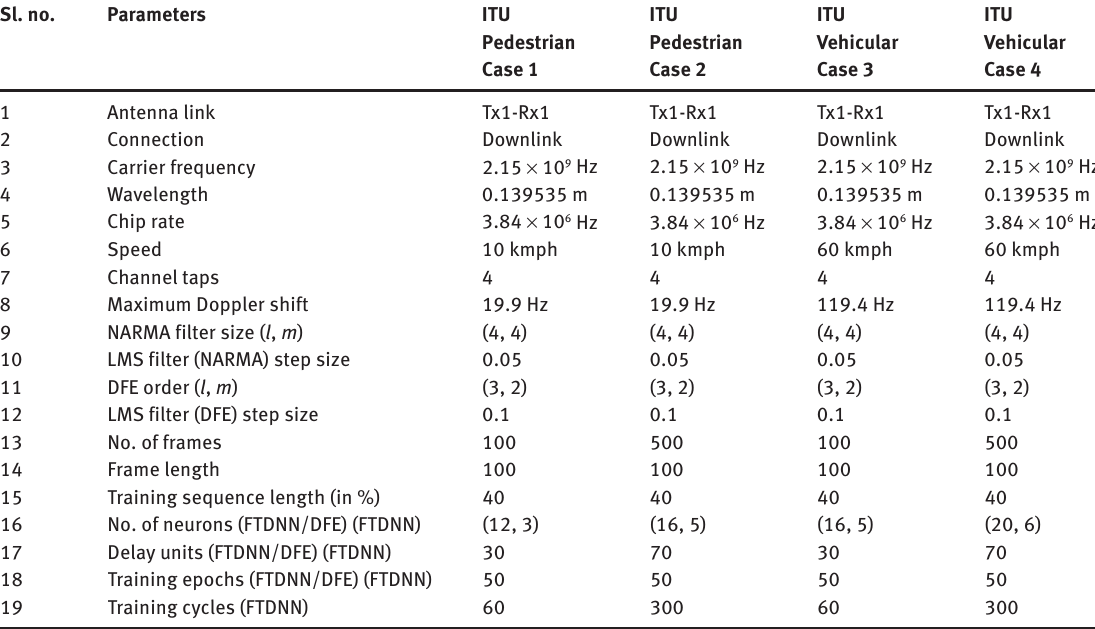
Table 1: Parameter Specification. Sl.